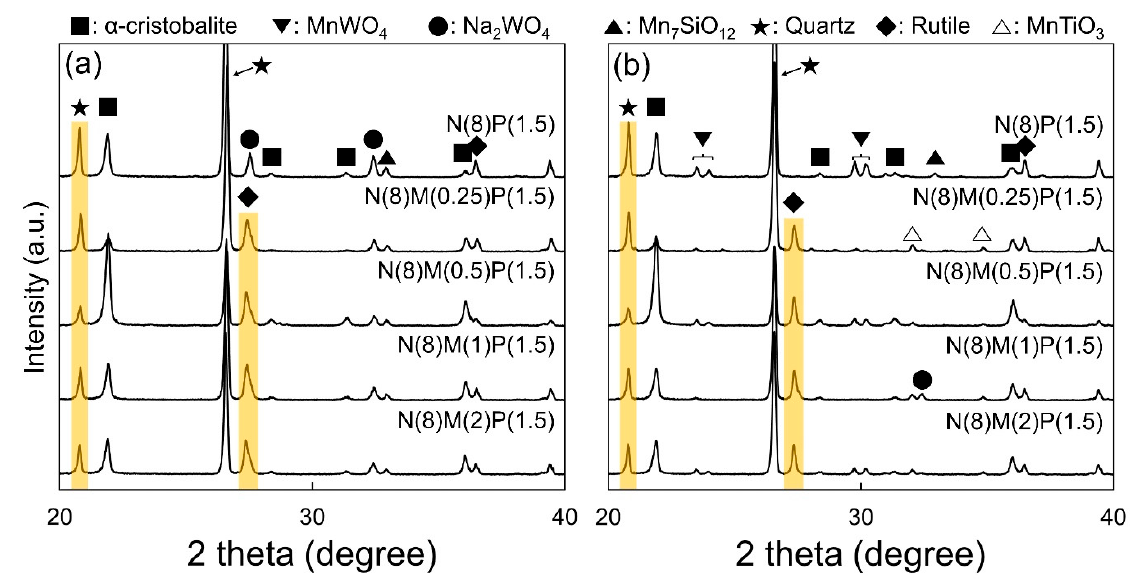
Figure 3. X-ray diffraction patterns of ( a ) fresh and ( b ) spent catalyst pellets depending on inorganic binders.